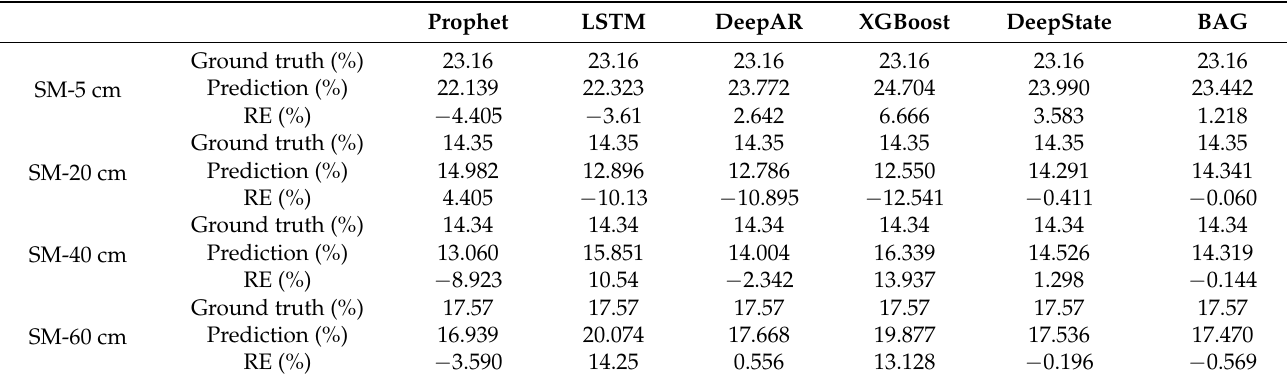
Figure 4. Comparison of prediction errors of different methods. Table 8. Comparison of different prediction models of DataA.